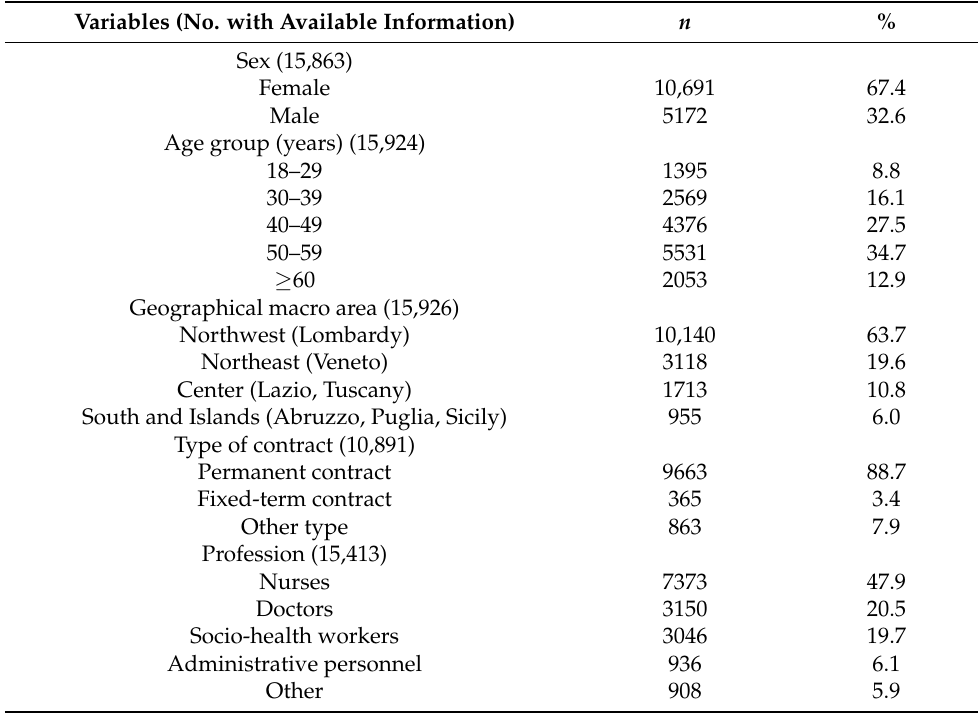
Variables (No. with Available Information)